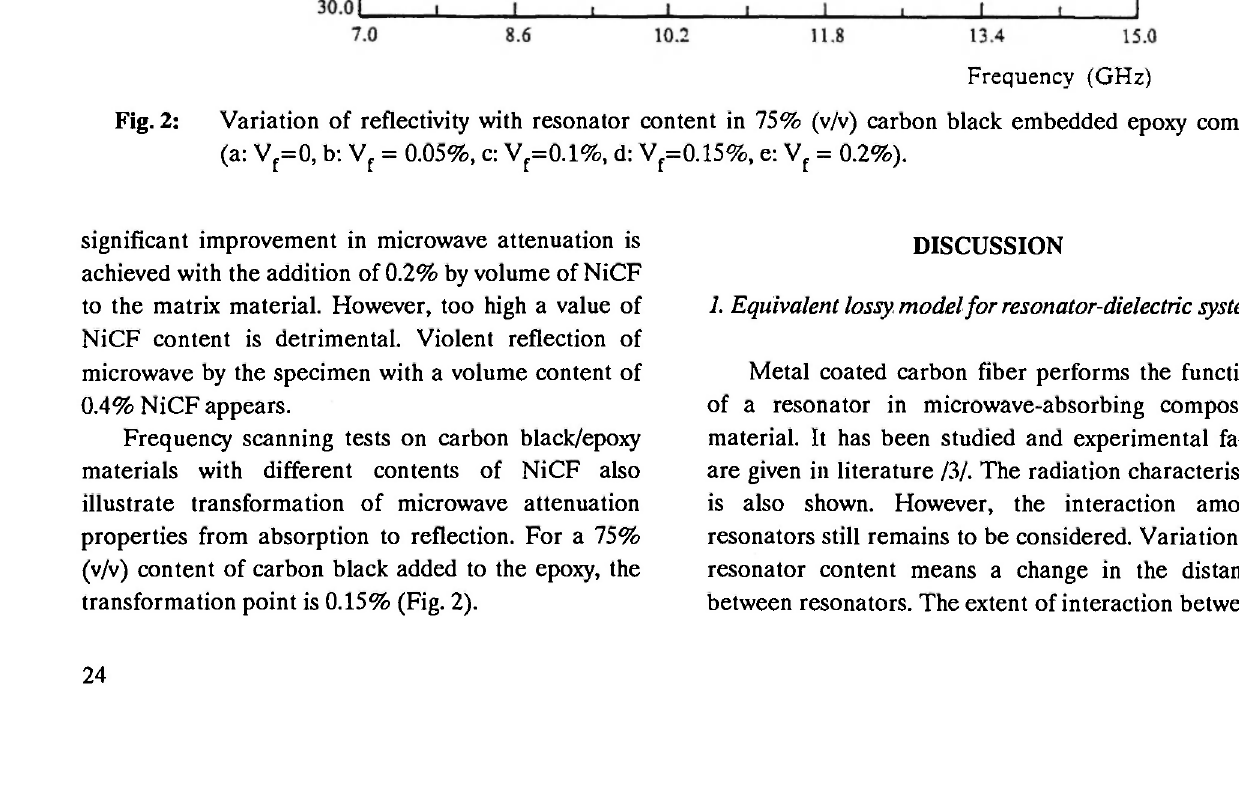
Fig. 1: Dependence of reflectivity on the content of NiCF resonators. (70% Mn-Zn ferrite contained in matrix, a: V { =0, b: V f =0.2%, c: V f =0.3%, d: V f =0.4%, e: V f =0.5%.)